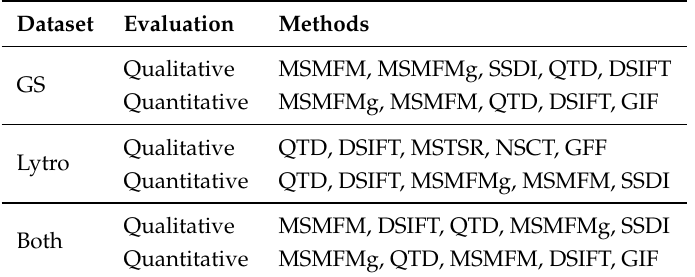
Table 8. Summary of qualitative and quantitative performance evaluation results. Only the five best performing methods are considered. In the case of quantitative evaluation, the metrics are ranked from high to low. Whereas in the case of qualitative evaluations, this ranking is not vivid—few algorithms might be indistinguishable by the visual